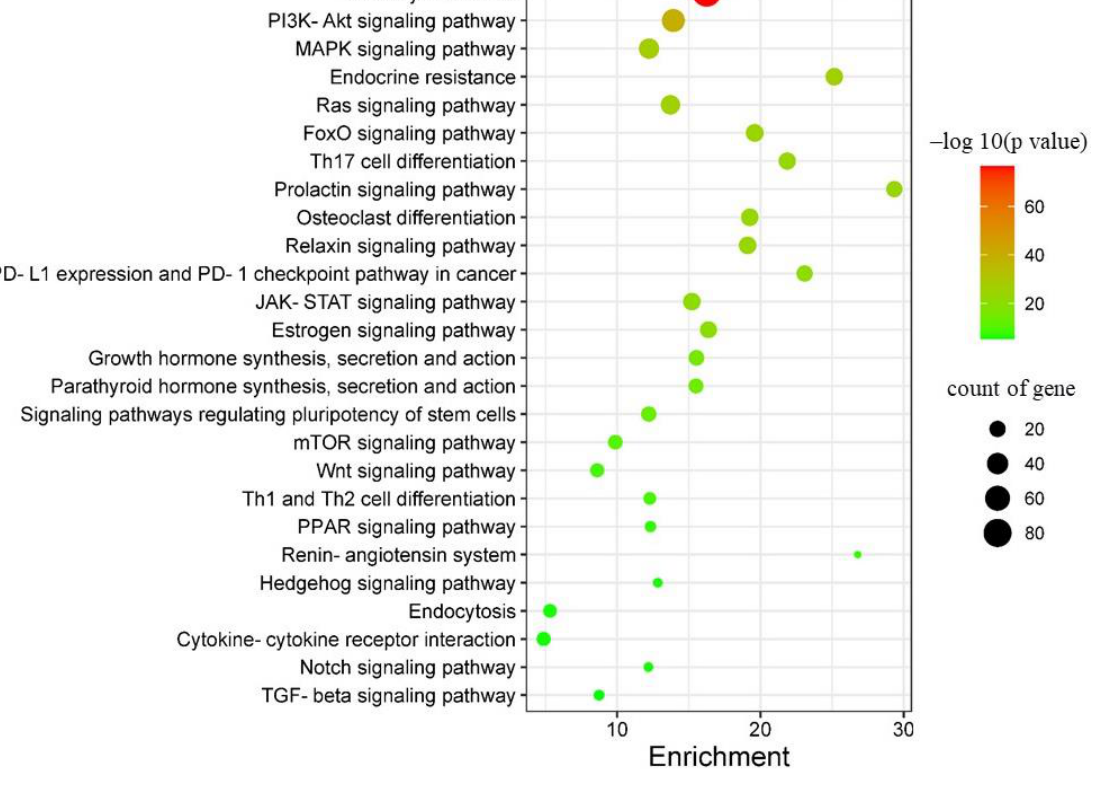
Figure 5. The KEGG pathways associated with GD-NAIs against CML.